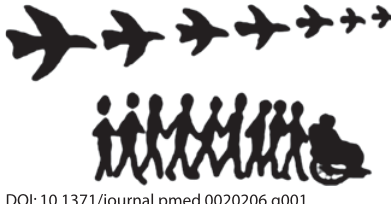
Figure 1. Logo of the BrainTalk Communities—Online Patient Support